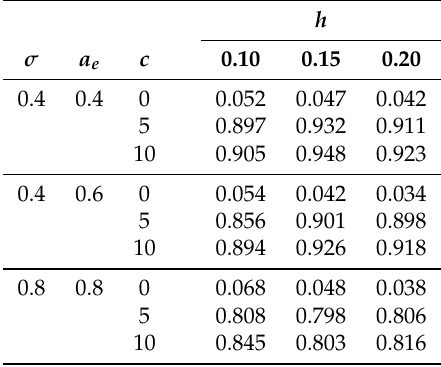
Table 1. Proportion of rejections of the null